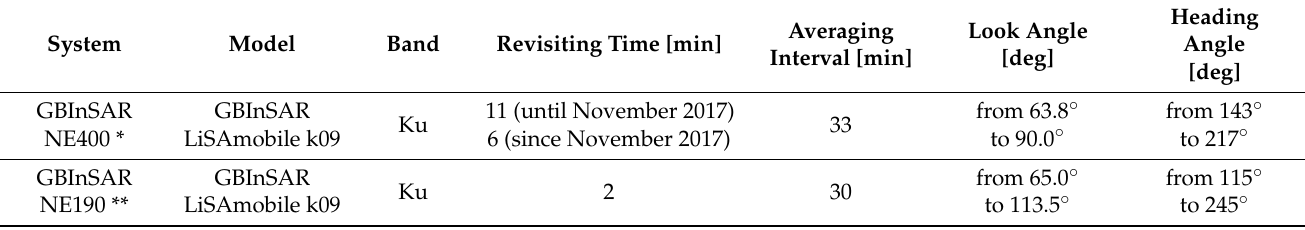
Table 2. Technical features of the two GBInSAR devices installed at Stromboli volcano.